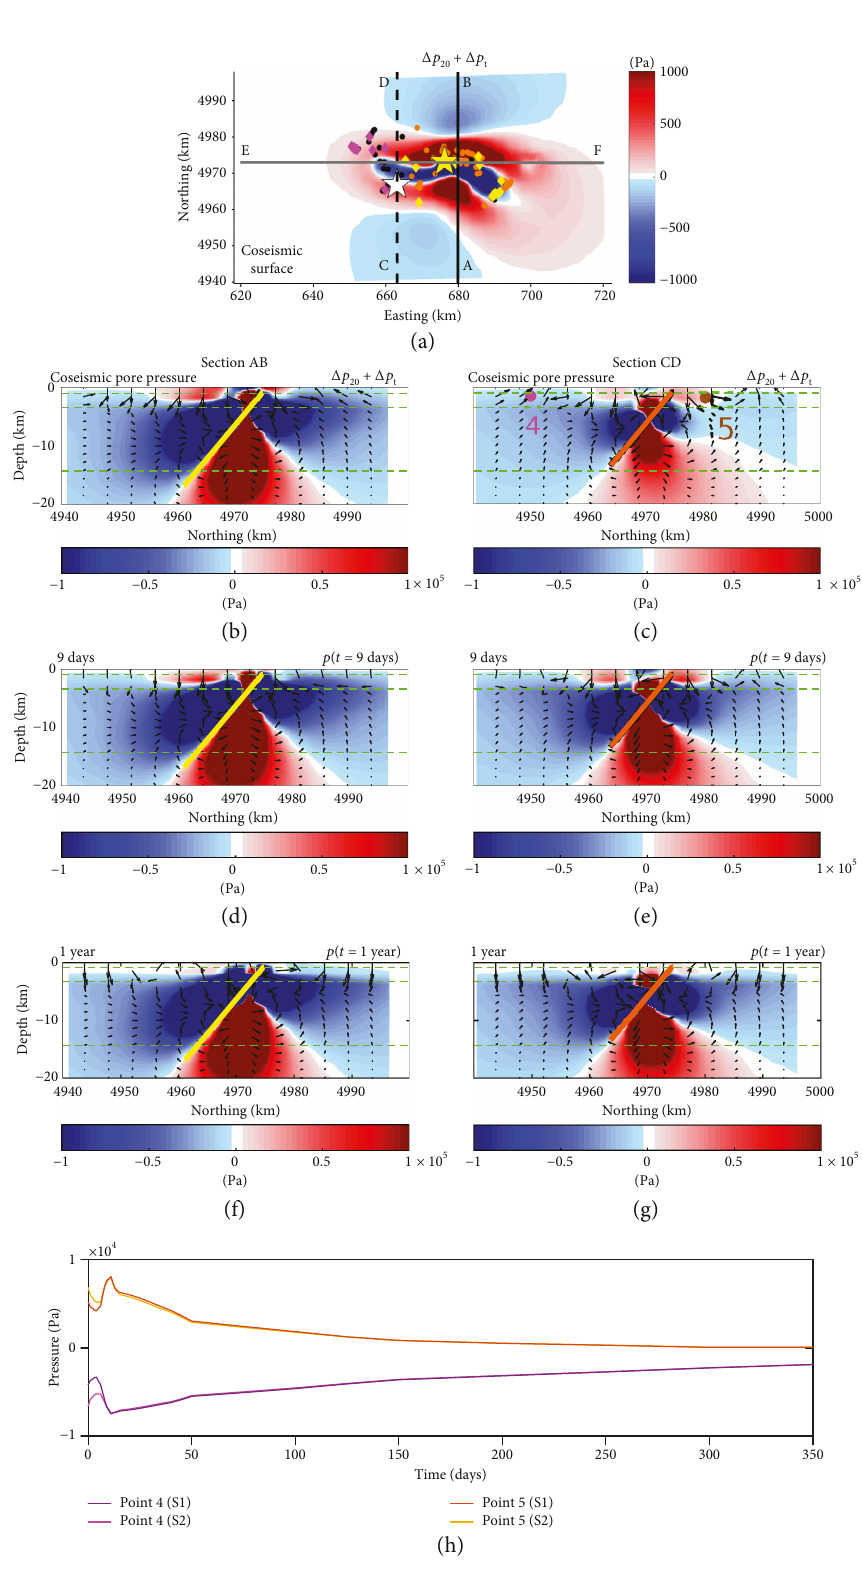
Figure 5: Pore-pressure evolution p t for scenario S2, Δ p (d and f) Pore-pressure plot for section AB at t = 9 days and 1 year. (e and g) Pore-pressure for section CD at t = 9 days and 1 year. Yellow and orange lines: intersections with the Ferrara and the Mirandola faults, respectively. Back arrows: fl uid fl ow direction (logarithmic scale). Green dashed lines represent the elastic and hydraulic discontinuities. (h) Pore-pressure evolution in S1 and S2 in (c) points 4 and